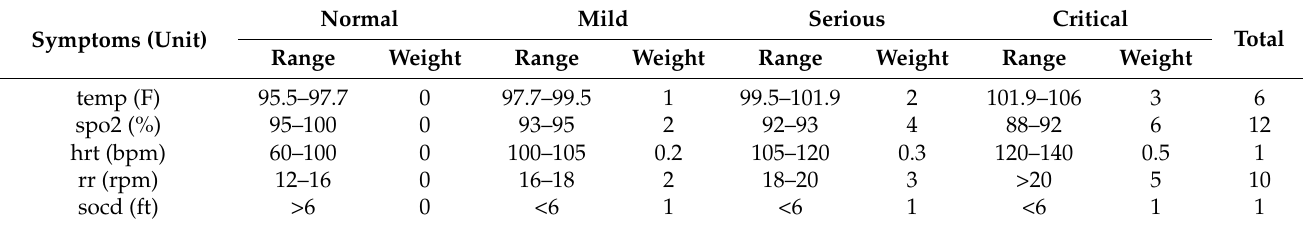
Table 5. The refined feature weights.